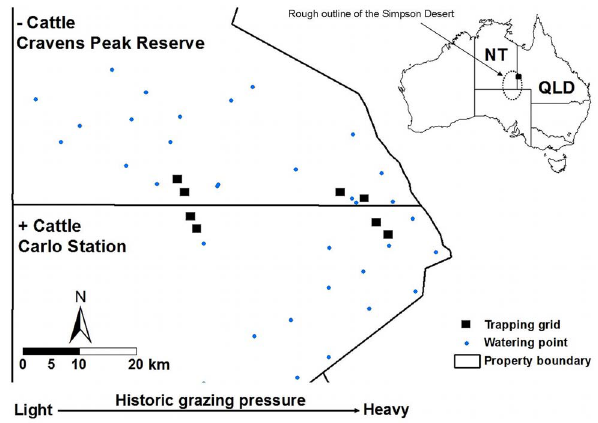
Figure 1. Location of trapping grids on Cravens Peak Reserve and Carlo Station. Trapping grids (not to scale), artificial watering points and the boundary fence between the two properties, are shown. Increasing historical grazing intensity from west to east is indicated by the arrow at the bottom. The inset shows the location of the Simpson Desert within Australia. NT=Northern Territory, QLD=Queensland.